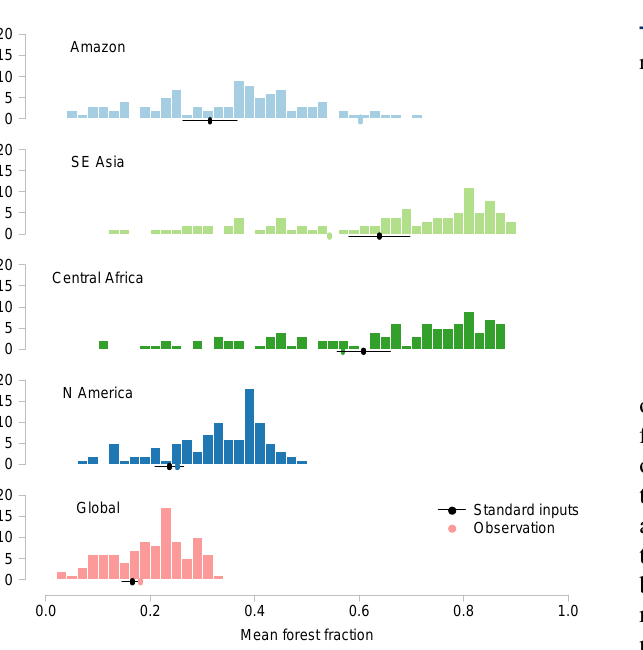
Figure 3. Histograms representing the number of ensemble mem- bers of a particular forest fraction in each region, as well as globally. Points plotted below the histograms represent the observed forest fraction (colours) and the forest fraction simulated at the “standard” parameters ± 1SD (black).